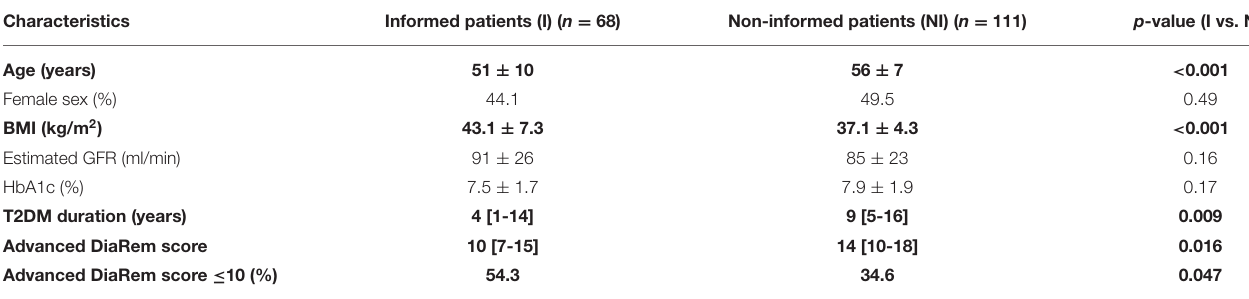
TABLE 3 | Comparison of characteristics between informed (I) and non-informed (NI) eligible diabetic patients for metabolic surgery. Characteristics